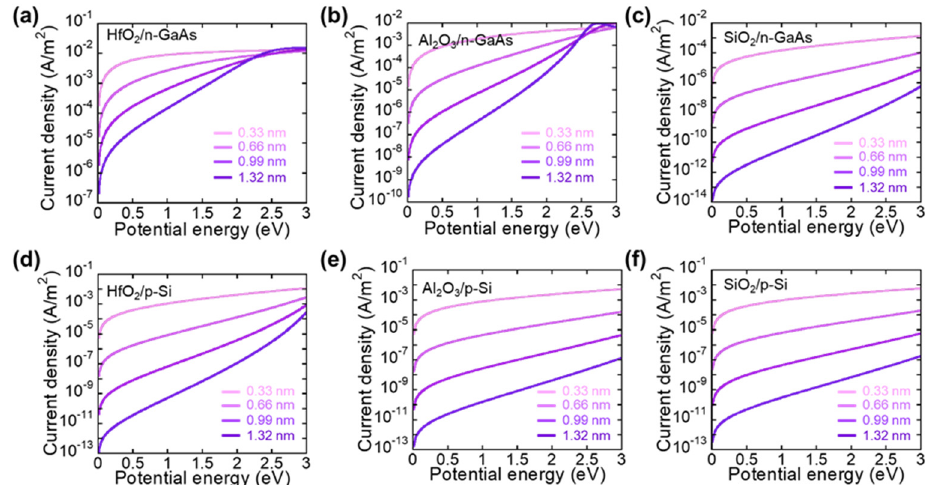
Figure 2. Tunneling probability of an electron across the UT interfacial layer with different thick- nesses: ( a ) HfO 2 /n-GaAs, ( b ) Al 2 O 3 /n-GaAs, and ( c ) SiO 2 /n-GaAs; ( d – f ) tunneling probability of holes across these UT interfacial layers with p-Si with different thicknesses.